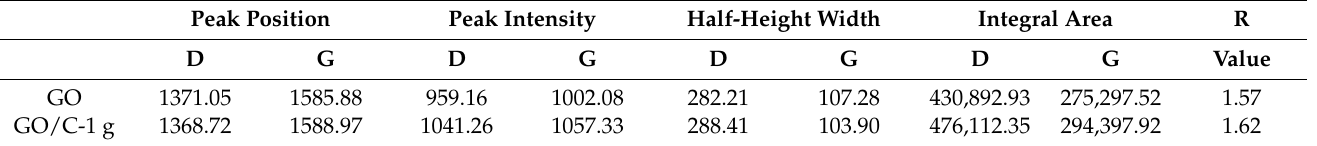
Figure 3. The Raman spectra of graphene oxide (GO) and GO plus 1 g MCC composite (GO/C-1 g). Table 1. The analysis result of Raman spectra.